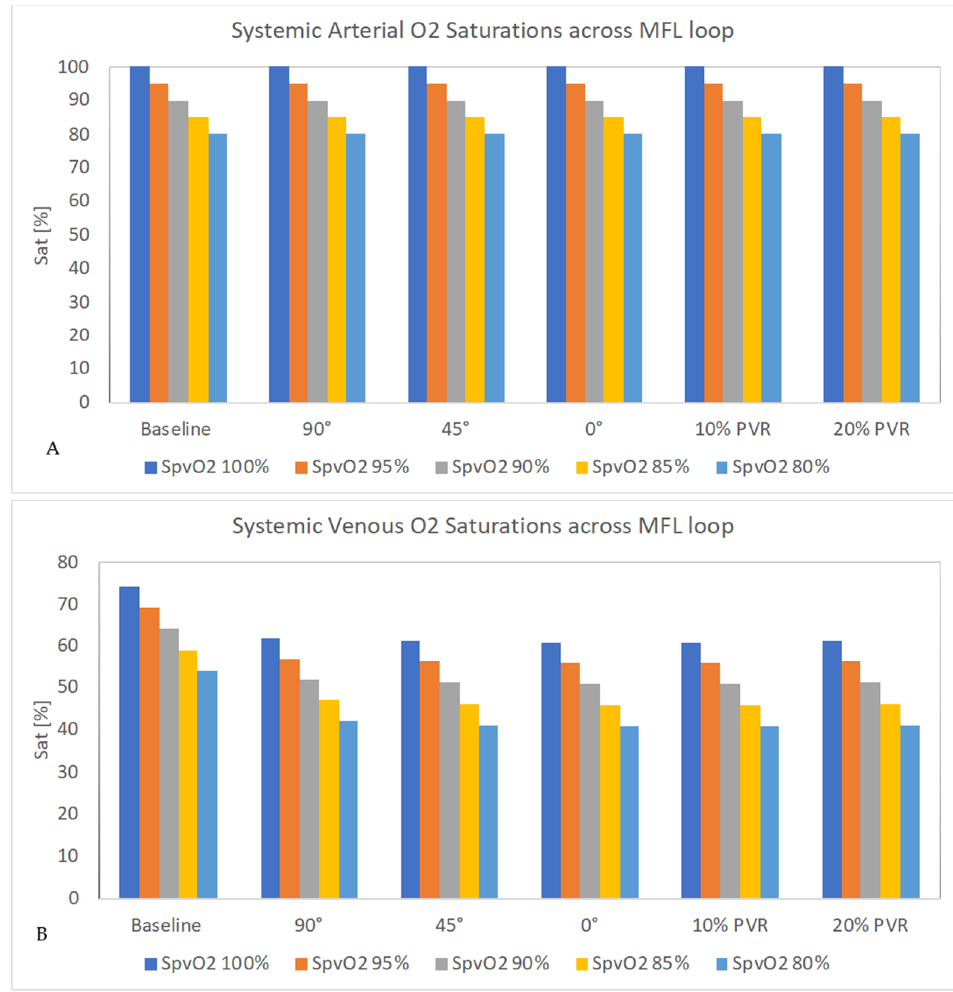
Figure 19 . Systemic arterial ( A ) and venous ( B ) oxygen saturation for various pulmonary venous saturation (SpvO2) in all the models explored.